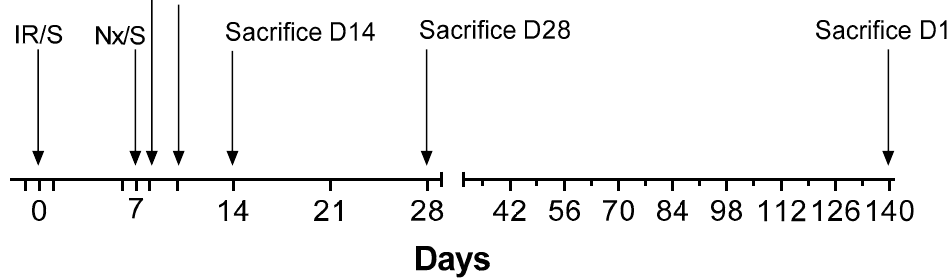
Figure 9. Overview of the interventions in each experiment of various durations. All major interventions are marked with arrow on the timeline. The time when blood and urine samples were taken after day 14 are marked as major and minor ticks, respectively.